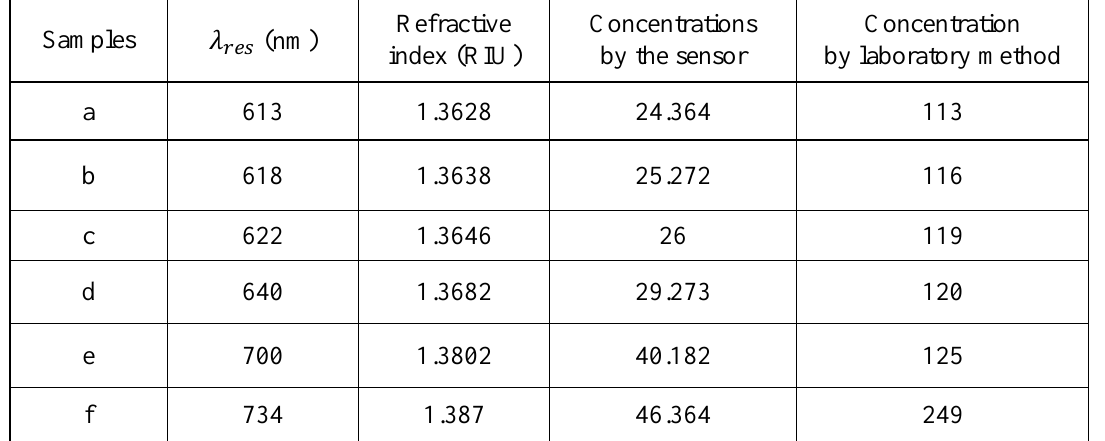
Table 1: Values of the refractive index and concentration for various resonance